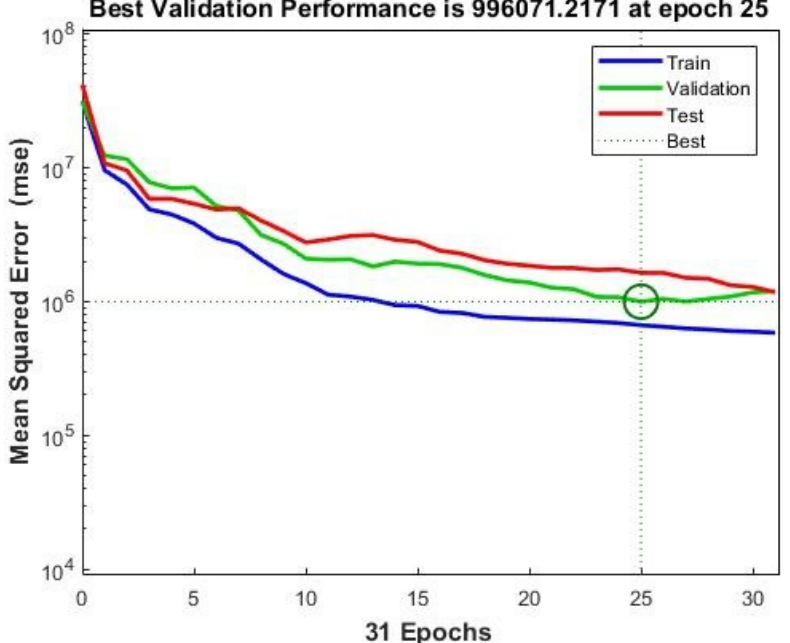
Figure 6. Training, validation, test, and best observed results.